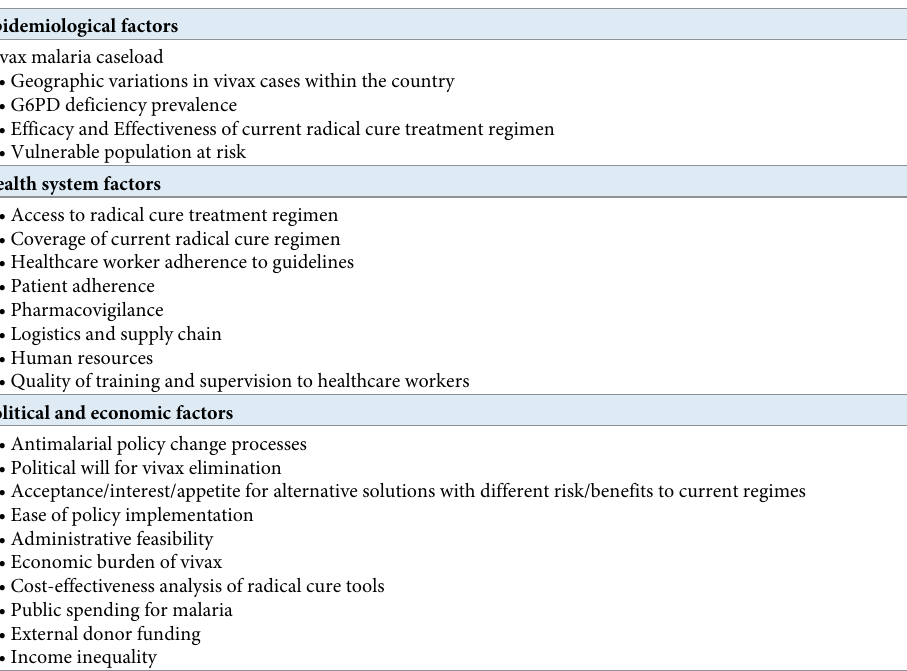
Table 4. Initial list of key variables for discussion with